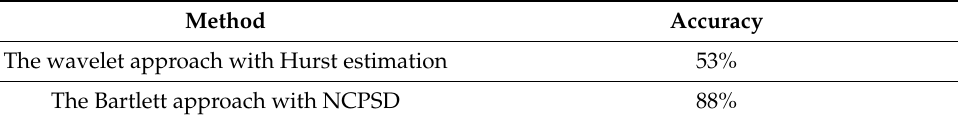
Table 1. Detection accuracy of LDoS